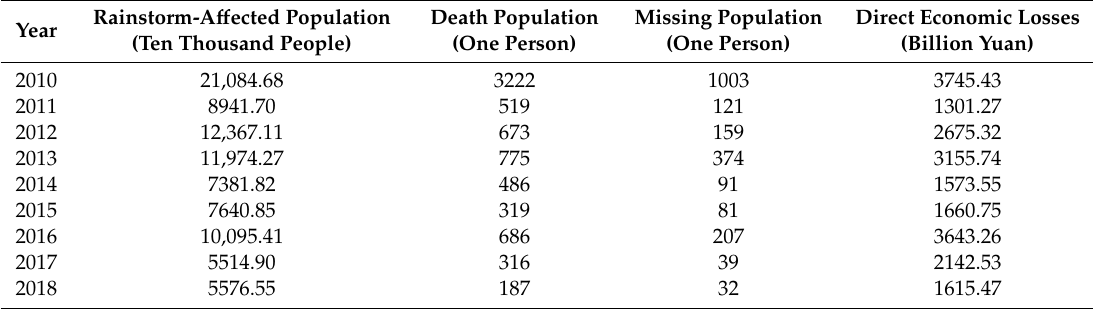
Table 1. Statistics of the rainstorm-a ff ected population, deaths, missing persons, and direct economic losses from 2010 to